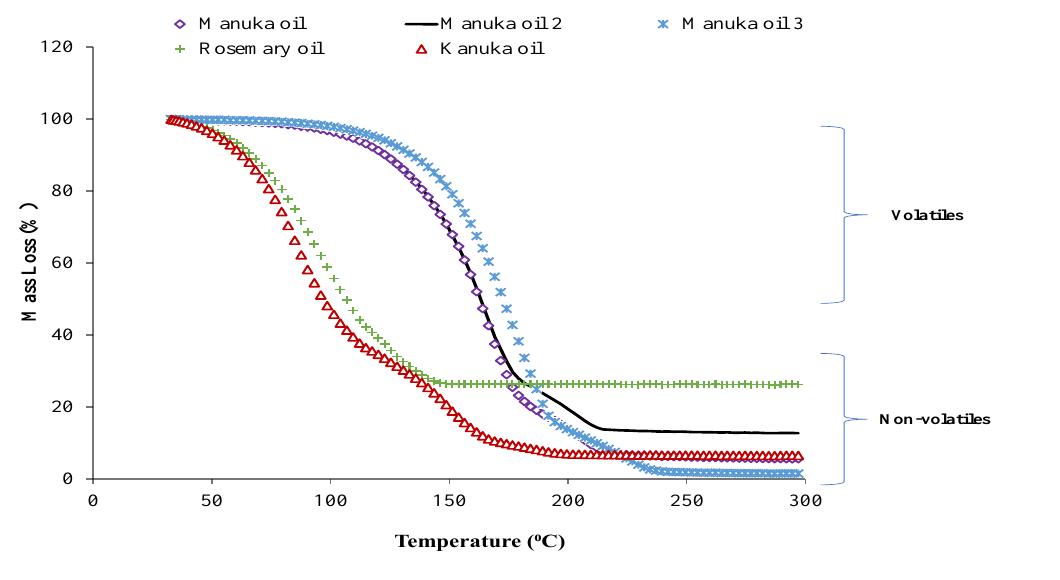
Figure 2. Thermogravimetric analysis of manuka 1 (5% triketones), 2 (25% triketones), 3 (40% triketones), kānuka , and rosemary oils. Table 1. The inhibition zone values were observed for m¯anuka, kanuka, and rosemary oils against different